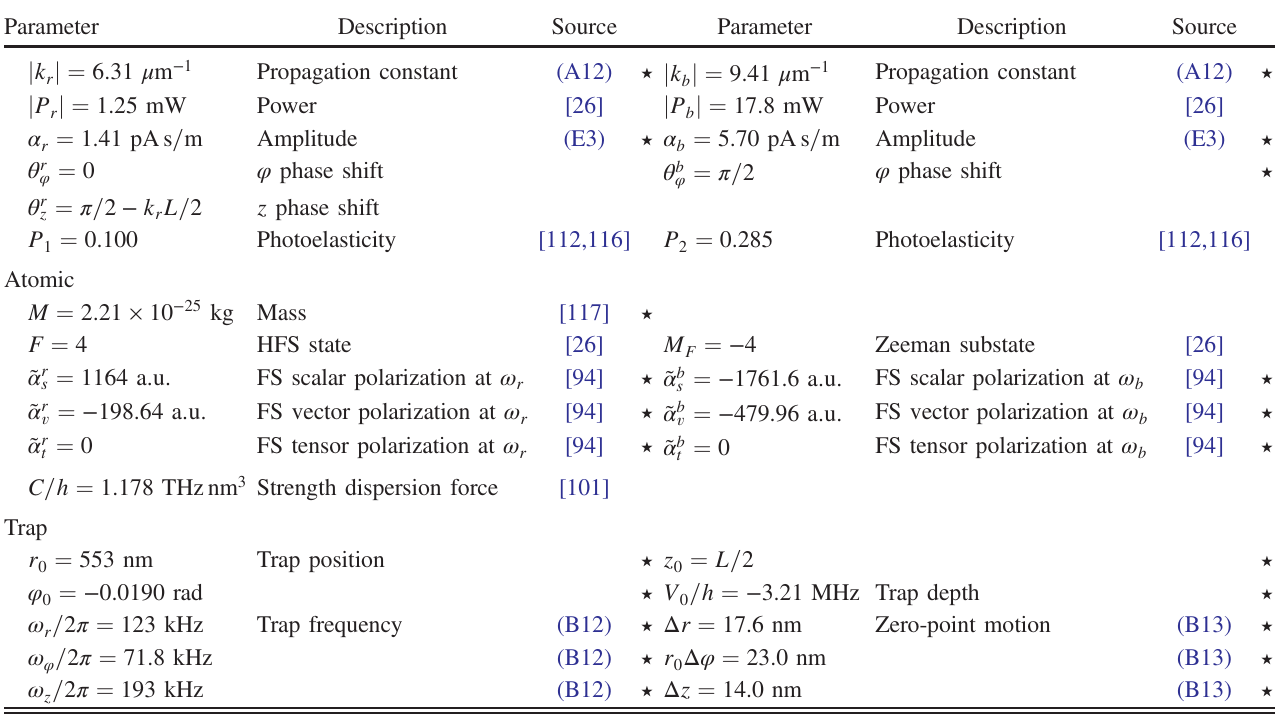
6 2 S 1 = 2 interacting with the red-detuned ( r ) and blue- detuned ( b ) light field. The atomic unit of